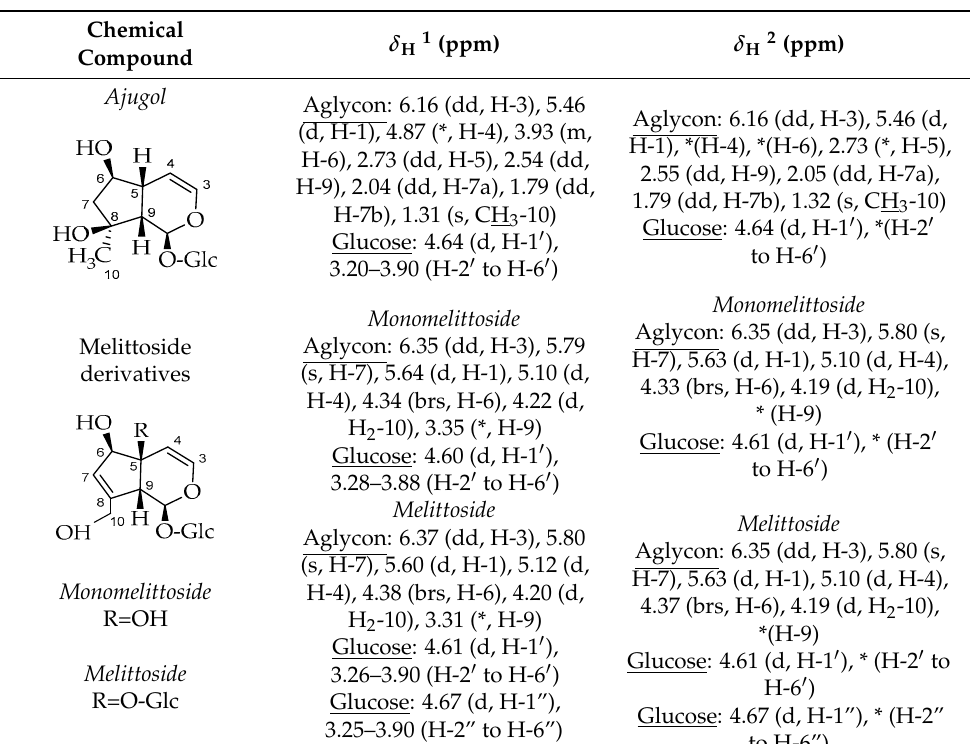
Table 1. The main hydrogen chemical shifts of the 1 H-NMR spectra of ajugol and derivatives of melittoside and their corresponding peaks in 1 H-NMR spectrum of the infusion of S. perfoliata subsp. perfoliata (CD 3 OD, 400 MHz).